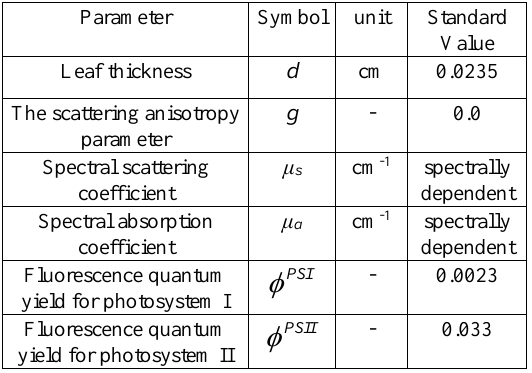
Table 1. The input parameters for the MC model